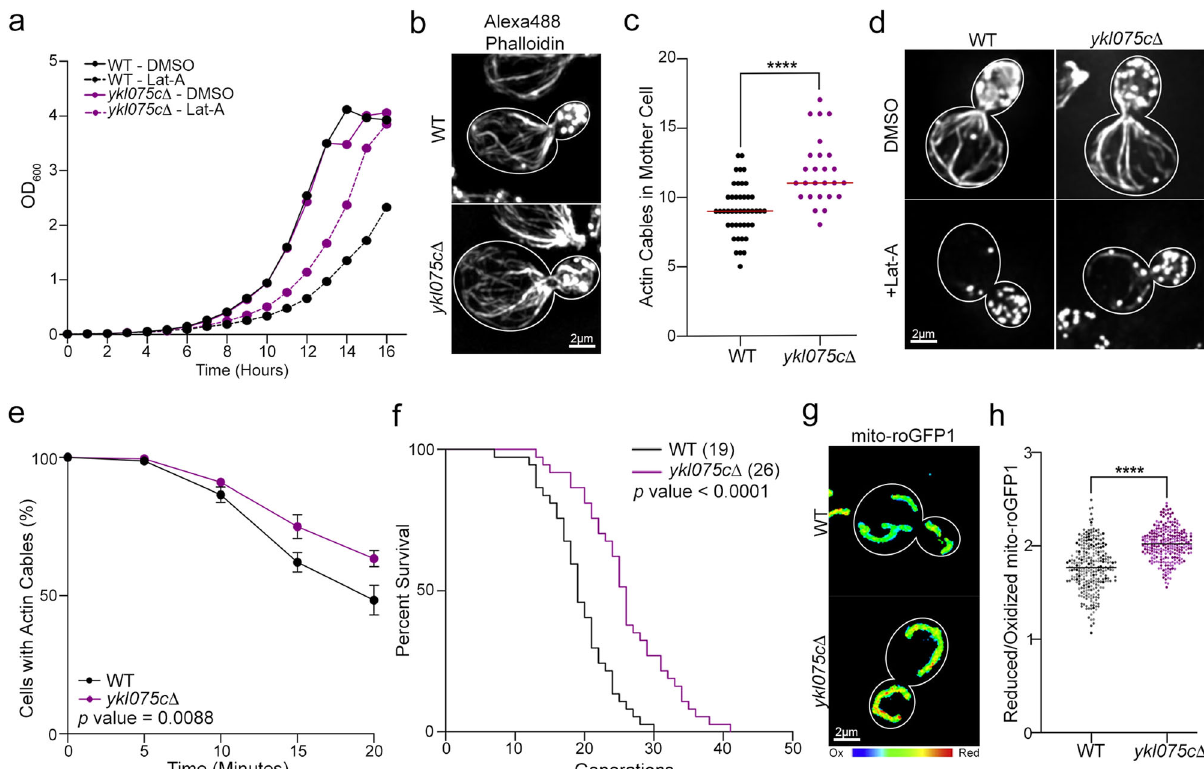
Fig. 2 Identi fi cation of a gene ( YKL075C ) that affects actin cable stability, mitochondria, and lifespan. a Growth curves of WT and ykl075c Δ cells treated with vehicle (DMSO) or 2 µ M Lat-A for 16 h. Data from a representative trial is shown ( n = 3 trials). b Representative images of Alexa488- phalloidin stained F-actin of WT and ykl075c Δ cells. c Actin cable abundance in mother cells of mid-log phase WT and ykl075c Δ cells. n = 44 cells (WT) and 26 cells ( ykl075c Δ ). Data from a representative trial is shown ( n = 3 trials). p value (1.00e − 06 ) was determined by a two-tailed non-parametric Mann- Whitney test. d Representative images of Alexa488-phalloidin stained F-actin of WT and ykl075c Δ cells treated with vehicle (DMSO) (top panels) or 2 µ M Lat-A for 20 min (bottom panels). e Quantitation of actin cables in WT and ykl075c Δ cells during treatment with 2 µ M Lat-A. Greater than 256 cells/ strain/timepoint were analyzed for n = 5 trials. Error bars: SEM. p value (8.8e − 03 ) was determined by simple linear regression analysis. f RLS of WT and ykl075c Δ cells determined by manual micromanipulation. n of cells/strain: 35 (WT) and 36 ( ykl075c Δ ). p value (1.23e − 06 ) was determined by the two- sided Mantel-Cox test. Data from a representative trial from n of 3 trials. g Representative images of mitochondrial redox state (reduced:oxidized ratio) visualized using mdito-roGFP1 in WT and ykl075c Δ cells. Higher numbers/warmer colors indicate more reducing mitochondria. h Quanti fi cation of mito- roGFP1 redox ratios in WT and ykl075c Δ cells. Combined n of cells/strain from three trials: 284 (WT) and 260 ( ykl075c Δ ). p value (< 1.00e − 15 ) was determined by a two-tailed non-parametric Mann – Whitney test. Scale bars, 2 µ